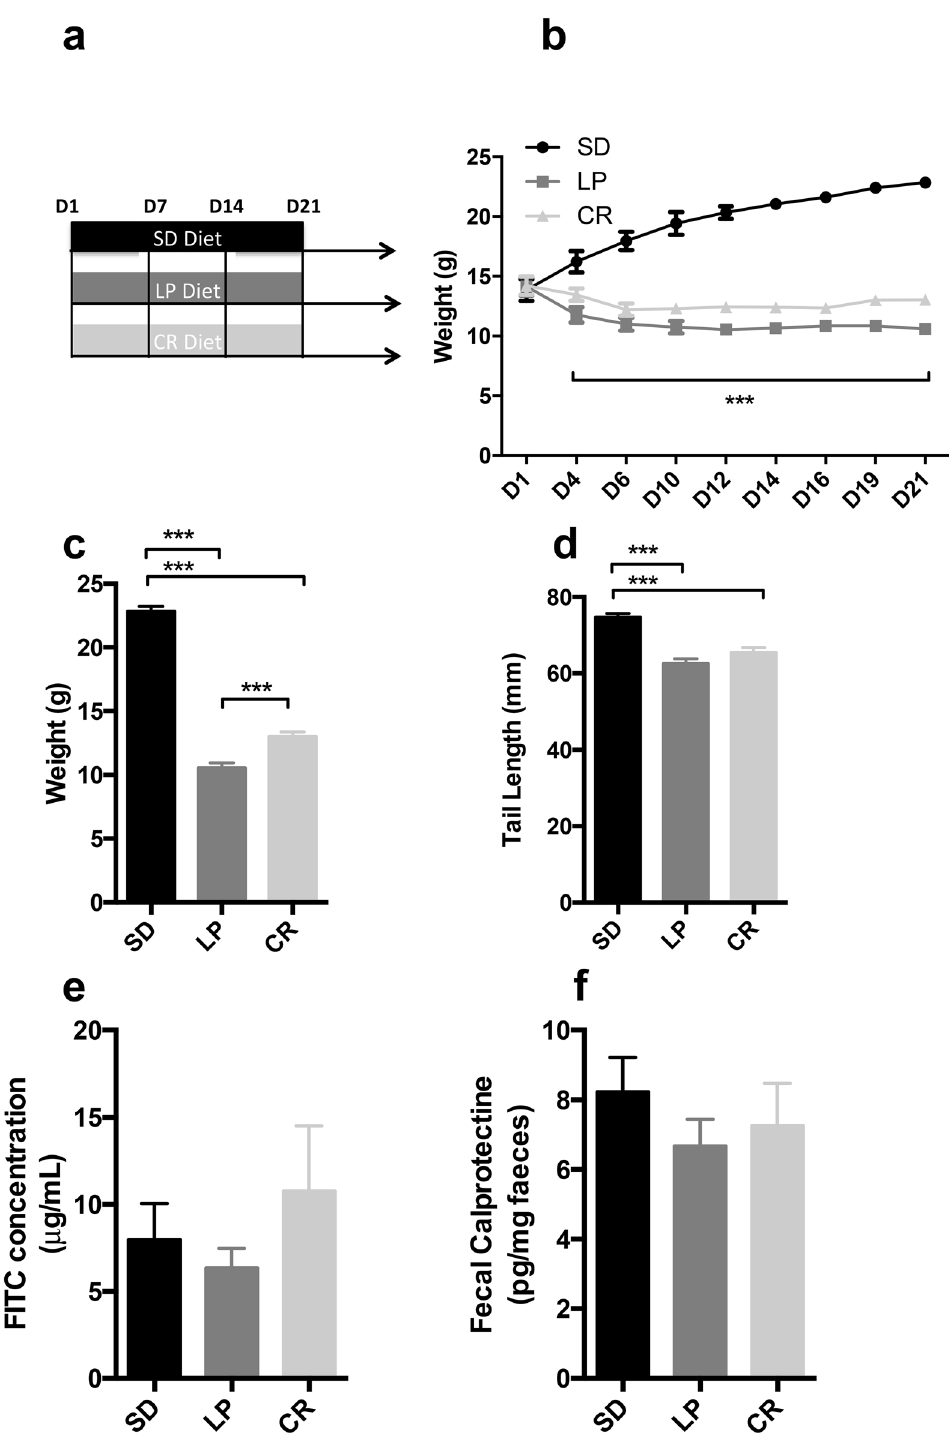
Figure 1. Growth, intestinal inflammation and permeability assessment in C57BL/6 mice fed a low protein, calorie restrictive or isocaloric standard diet. ( a ) 3-weeks-old mice were fed with standard, isocaloric low protein or 50% calorie restrictive diet post weaning for 21 days. ( b ) Body weight was recorded every 2 days until the end of the experimentation (n = 20 per group). Plots represent the mean ± SEM (***P < 0.001; 2-Way ANOVA). At D21, ( c ) body weight (n = 20 per group) and ( d ) tail length (n = 20 per group) were measured at the end of the experiment. Bars indicate the mean ± SEM One-way analysis of variance with post hoc Tukey’s test was performed (***P < 0.0001). ( e ) Bars indicate the mean ± SEM of the jejunal concentration of FITC into musculous side after 3 h after the beginning of ex vivo measurement of jejunal permeability using Ussing chamber at D21 (n = 20 per group). Kruskal Wallis test with post hoc Dunn’s Multiple Comparison Test was performed. ( f ) Bars indicate the concentration of fecal calprotectin in mice at D21 (n = 20 per group). One-way analysis of variance with post hoc Tukey’s test was used. SD, Standard diet; LP, Low protein diet; CR, Caloric